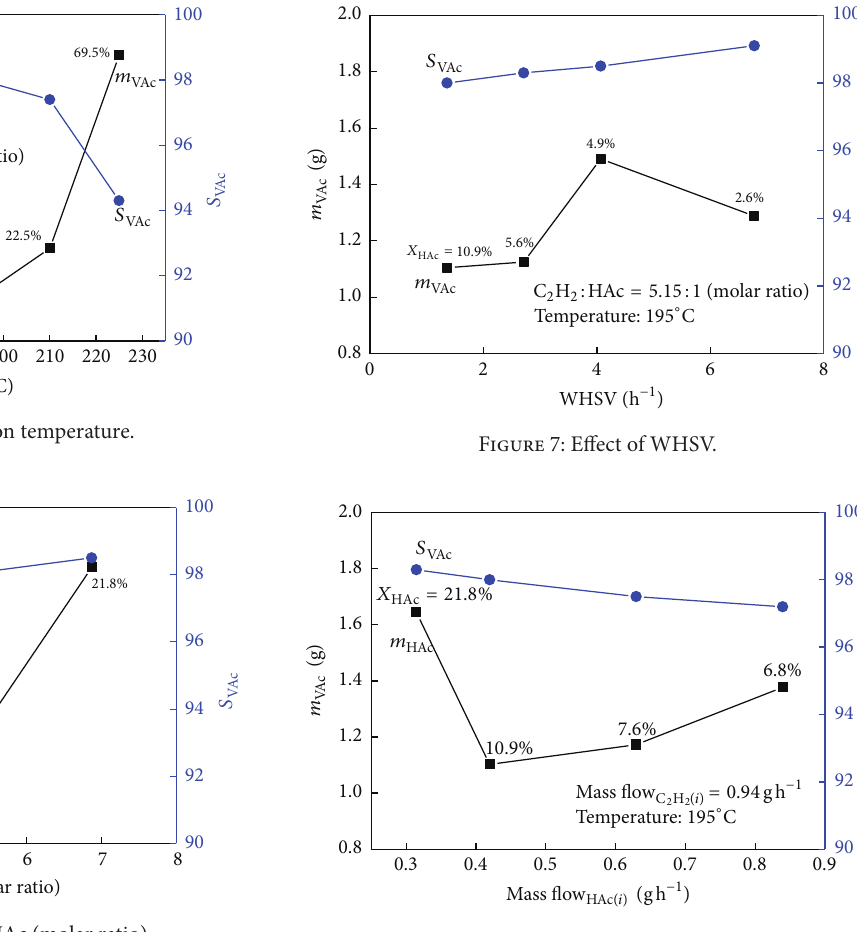
Figure 8: Effect of feed mass